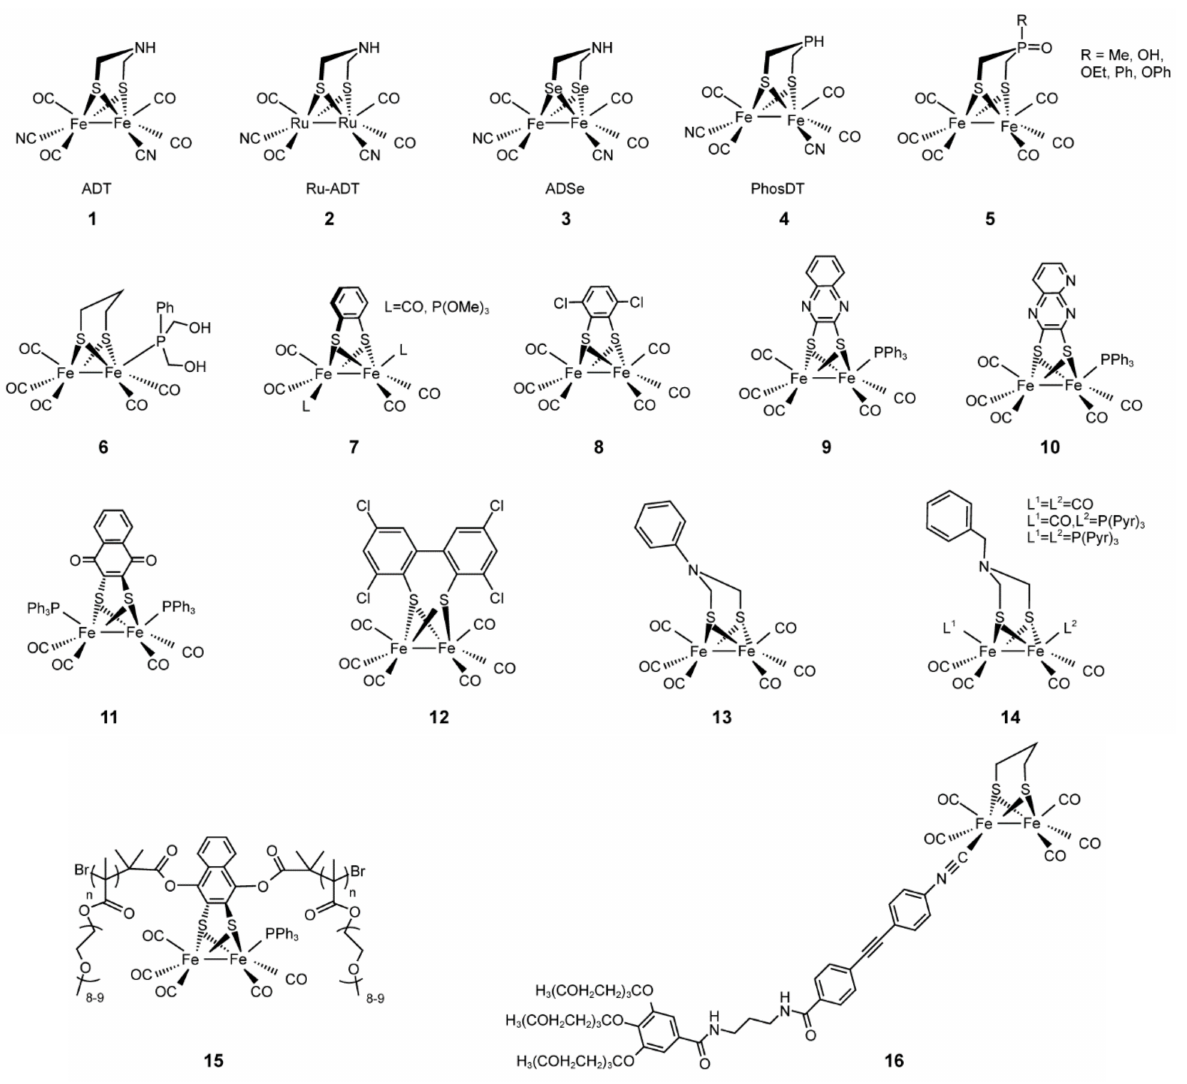
Figure 4. Various artificial hydrogenase mimics reported in the literature. References for these catalysts: 1 , [125]; 2 , [126]; 3 , [127]; 4 and 5 , [128]; 6 , [129]; 7 , [130]; 8 , [131]; 9 and 10 , [132]; 11 ,